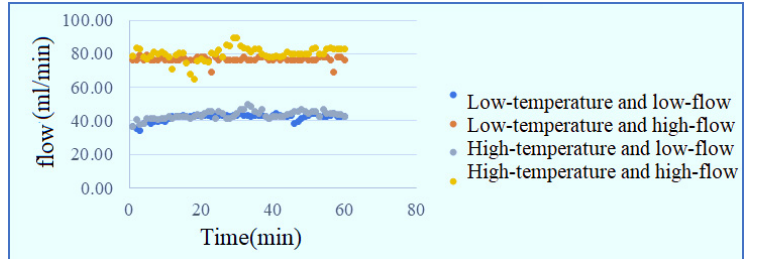
Figure 19. Curve diagram of flow at lower inlet of runner.